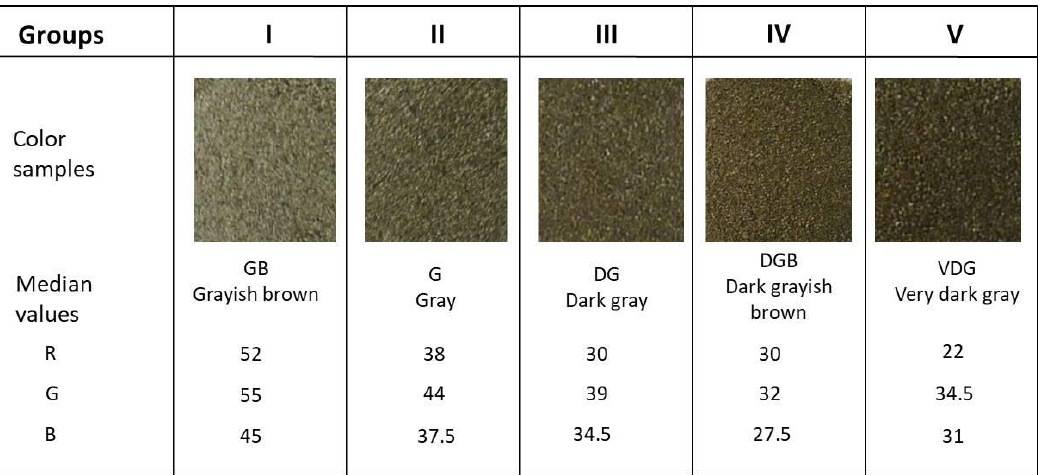
Figure 2. Grouping of road dust samples by color using the Munsell chart and with the average values in RGB. On the other hand, when presumably contaminating elements were used as depend- ent or classification variables, the discriminant analysis had 47% correctly classified cases. The very dark gray and greyish brown color samples reached 87.5% and 77.5% of correctly assigned cases, respectively (Table 2). On the contrary, gray colors obtained the lowest value of the percentage of correctly assigned cases. That is the formation of road dust groups by color, and considering the concentration of presumably contaminating ele- ments makes sense only in the case of very dark gray and grayish brown groups. Table 1. Congruence matrix between the color groups of road dust based on the Munsell color cards (discriminant variable) and those groups formed based on the color indices (classification variables). Current Color (Groups)